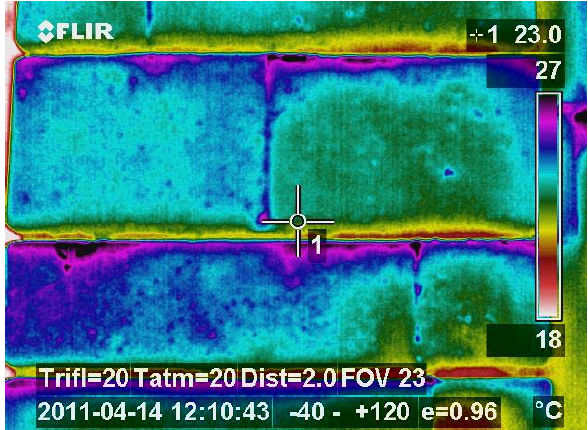
Figure 14. Stone cladding on façade of Royal Palace in